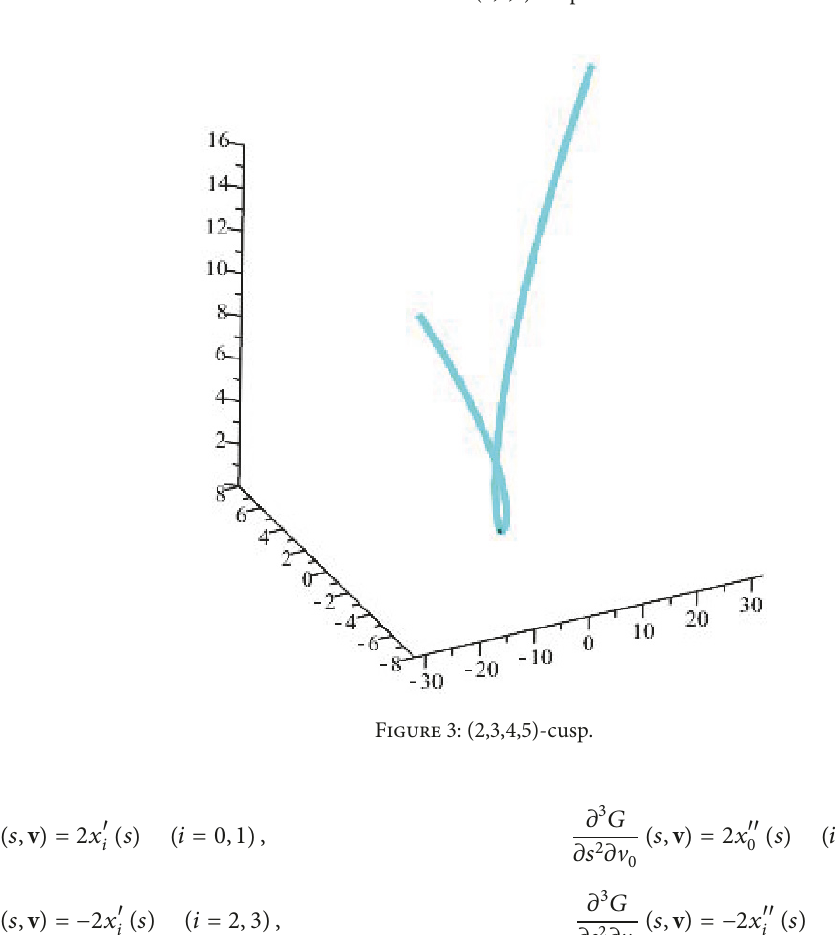
Figure 2: (2,3,4)-cusp.